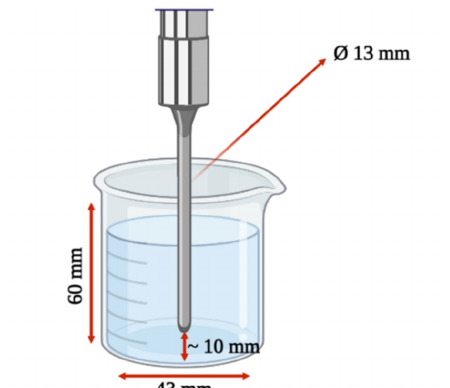
Figure 2. Schematic representation of the position of the ultrasonic probe in the glass beaker containing the aqueous SP